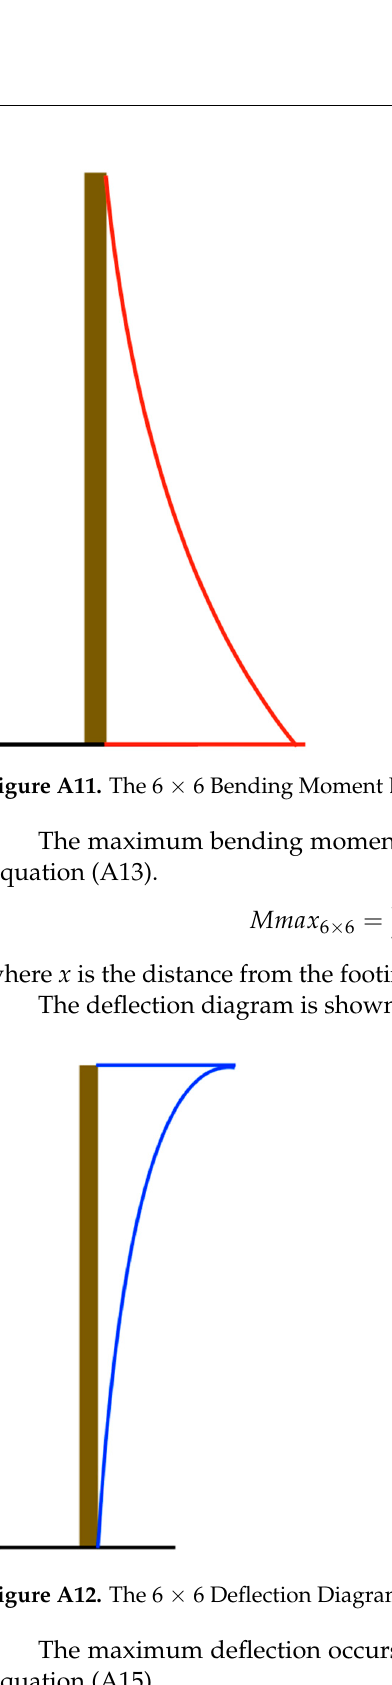
Figure A12. The 6 × 6 Deflection Diagram. The maximum deflection occurs at the top of the post, and can be calculated using Equation (A14). The compression load throughout the post varies as shown in Figure